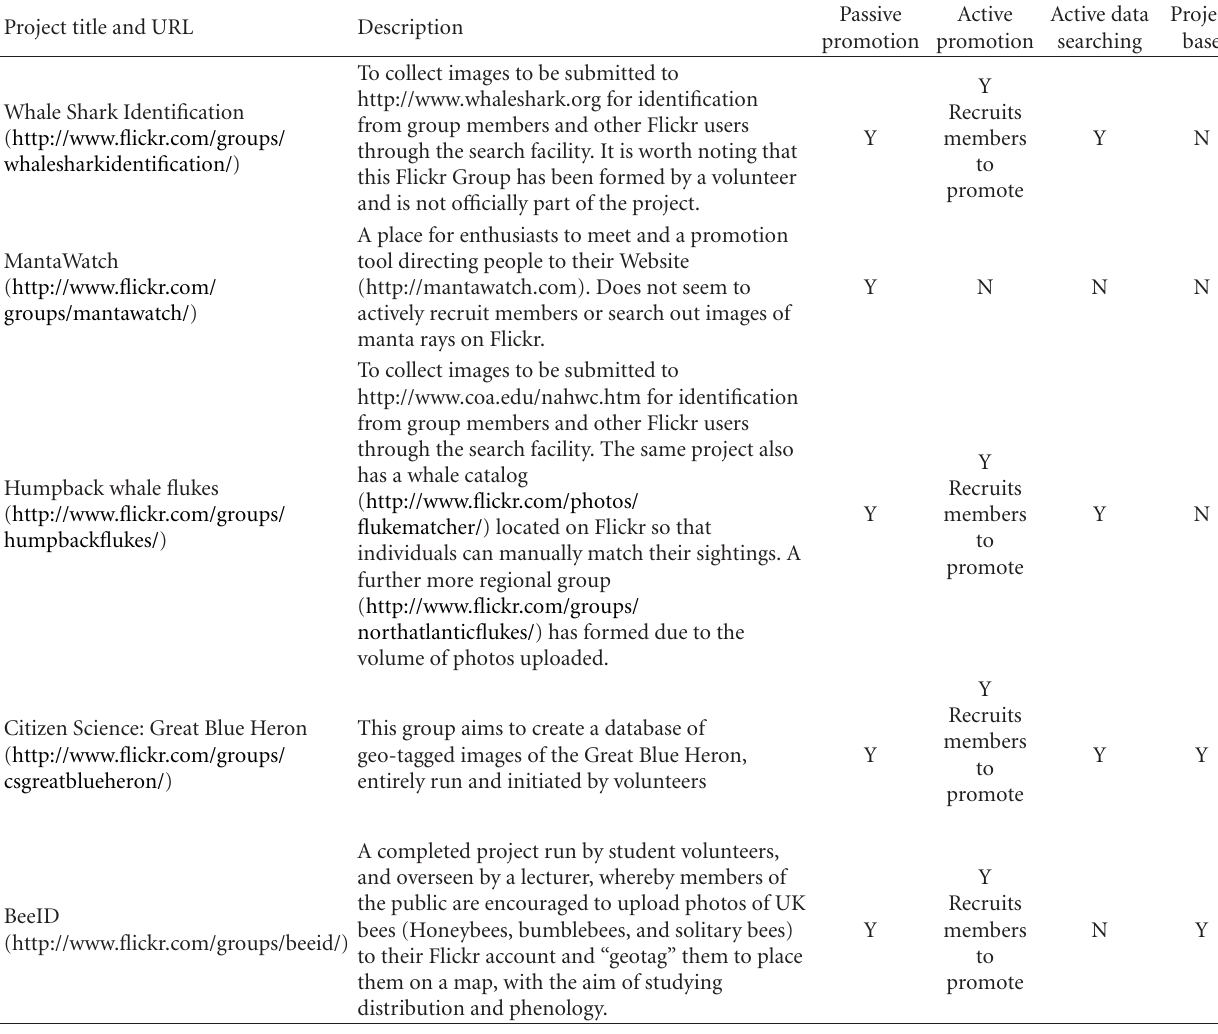
Table 4: Utilising Flickr for image-based citizen science